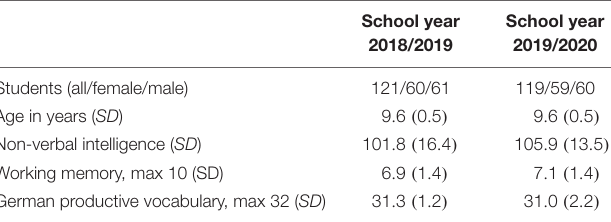
TABLE 1 | Overview of students by school years ( n = 240).